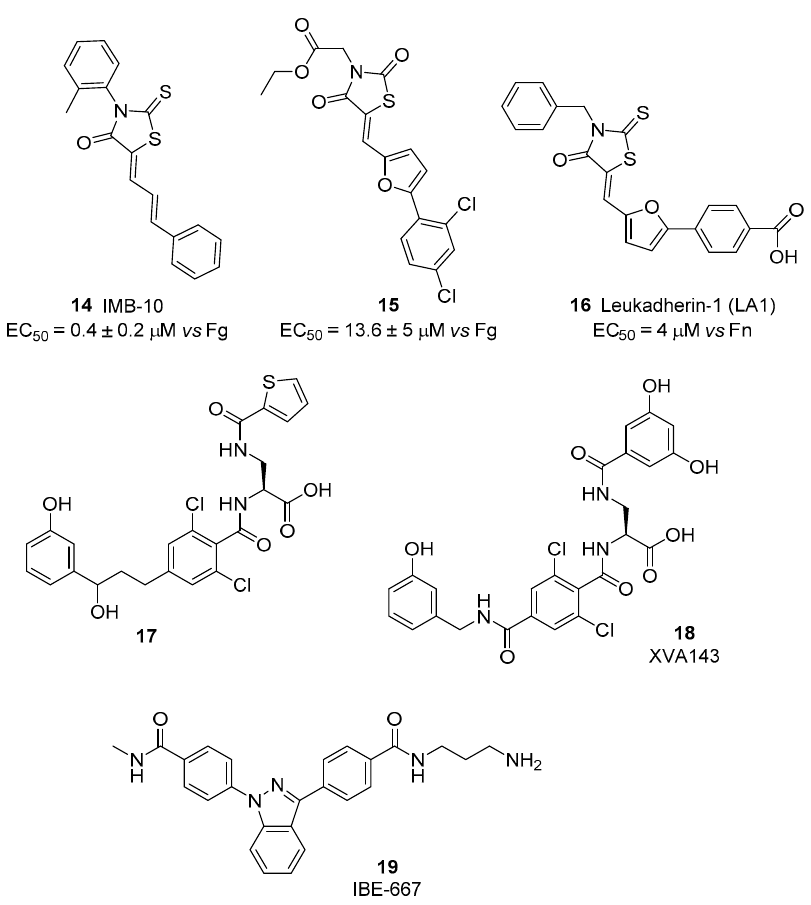
Figure 7. β 2 integrin agonists; data are expressed as EC 50 (mean±SD, nM) vs. ligand employed in cell adhesion